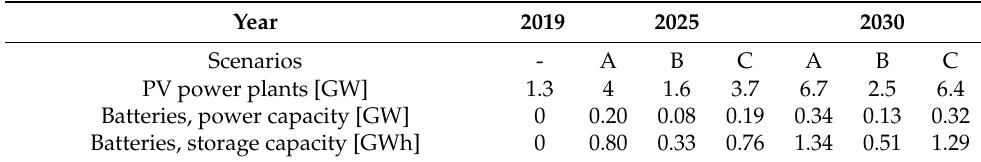
Table 1. Changes in the net installed capacities of PV power plants and energy storage systems in Hungary based on